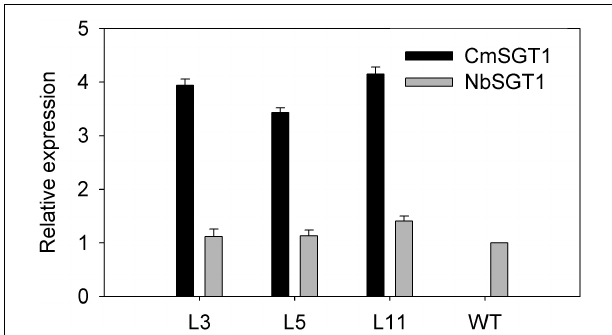
FIGURE 3 | Relative expression of CmSGT1 and NbSGT1 in transgenic or wild-type plants under normal growth conditions. N. benthamiana encodes NbSGT1 isoform. L3, L5, and L11 are three independent transgenic lines that overexpress CmSGT1 . Three biological triplicates were averaged and Bars indicate standard error of the mean. Data ( NbSGT1 expression in transgenic lines vs. NbSGT1 expression in wild-type plants) were analyzed by one-way ANOVA and unmarked ∗ denotes no statistical differences at p < 0.05.